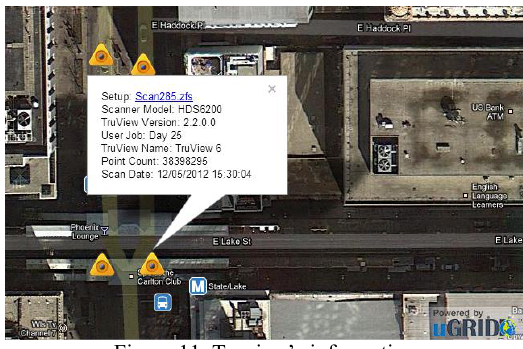
Figure 11. Truview’s